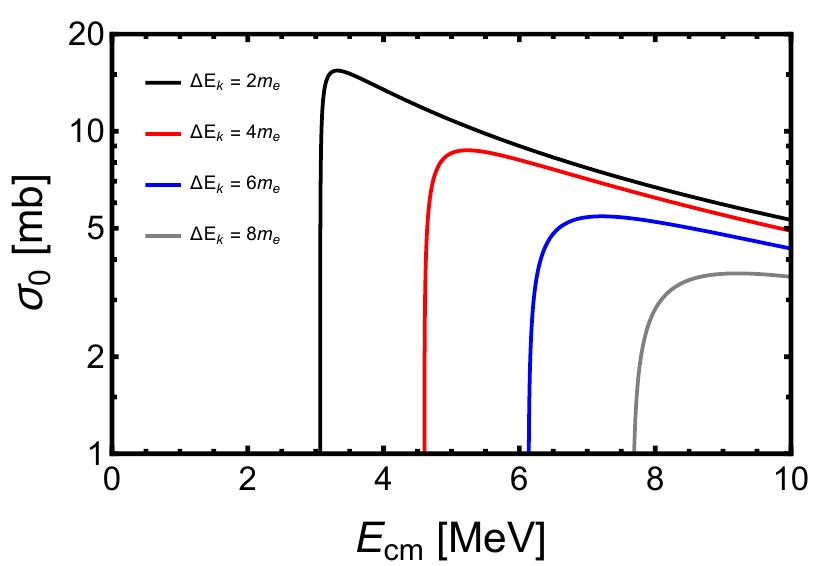
Figure 4. (Color online) Upper limit for the integrated cross-section for e + e − production in 12 C+ 12 C scattering below the Coulomb barrier for different values of ∆ E k . We stress that ∆ E k ≥